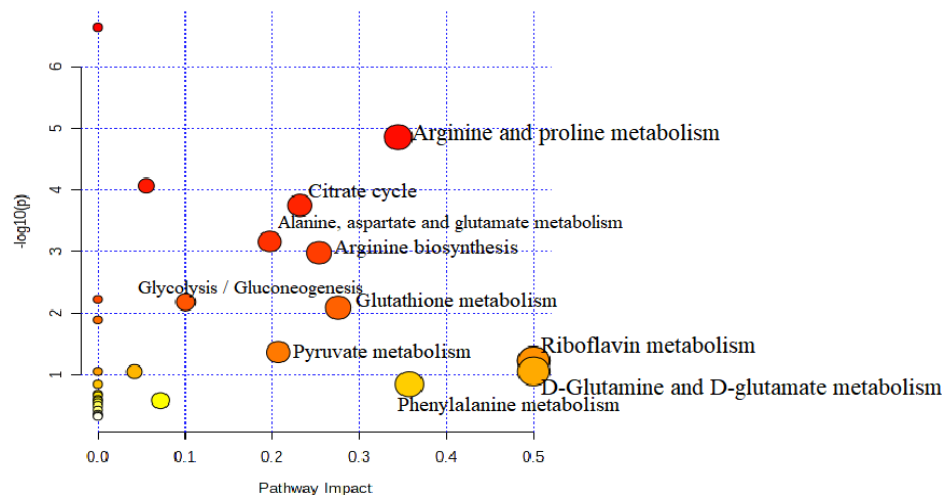
Figure 13. Summary of the pathway analysis of uninfected RBCs treated with AG.